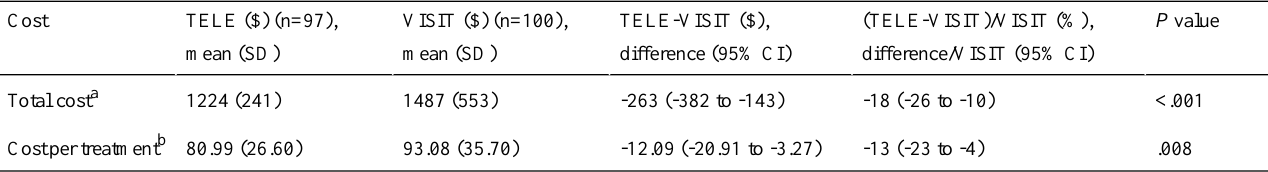
Table 3. Costs of telerehabilitation and home visits.